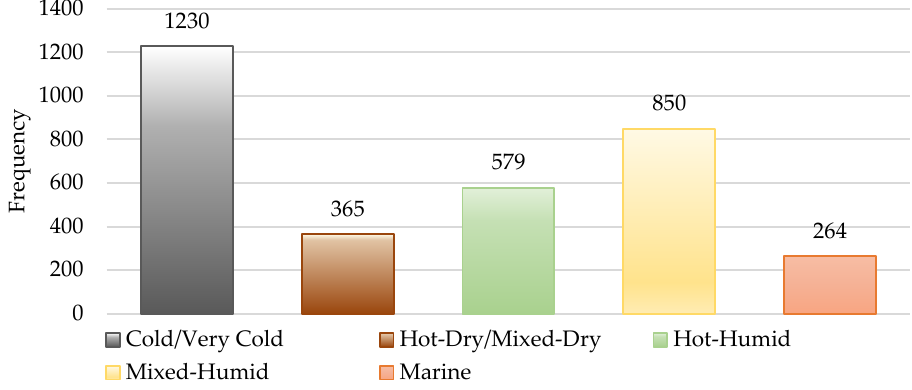
Figure 2. Distribution of homes per Building America climate zone (total n = 3288). Physical characteristics. The median house size in the sample was 2400 square feet Table 1. Total square footage (sqft) and square meters (m 2 ) of home per climate zones (total n = 3288). with a standard deviation of 1284.5 square feet (119.33 square meters) (Table 1). Median size also varied by region, with Cold/Very Cold climate homes being larger and hot-hu-